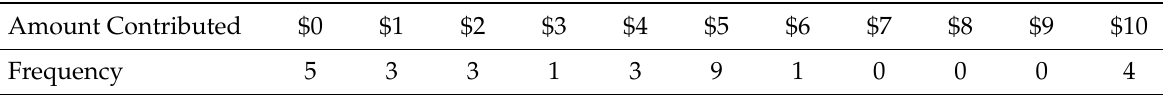
Table 1: Frequency distribution of dictator contributions. Amount